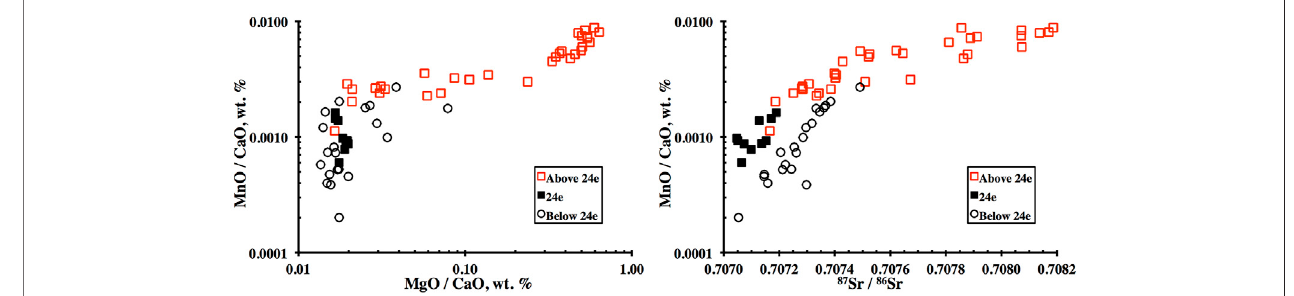
FIGURE 9 | Potential tracers of carbonate diagenesis: MnO/CaO vs MgO/CaO and MnO/CaO vs 87 Sr/ 86 Sr.